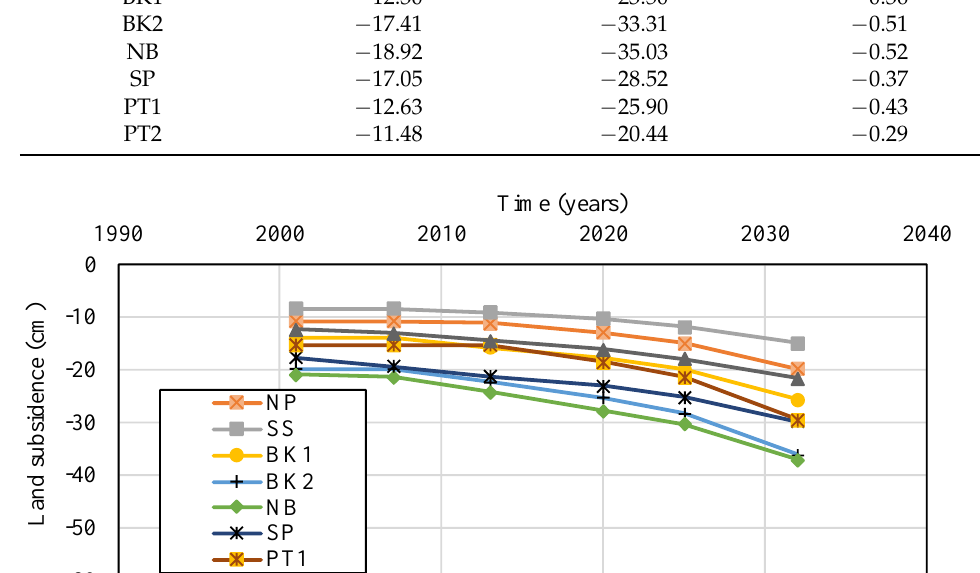
Figure 8. Displacement at each borehole.